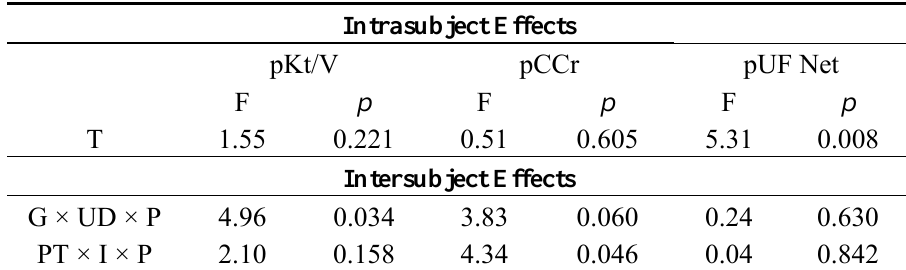
Table 8. Multivariate analysis of adequacy dialysis parameters of peritoneal fraction, intrasubject and intersubject